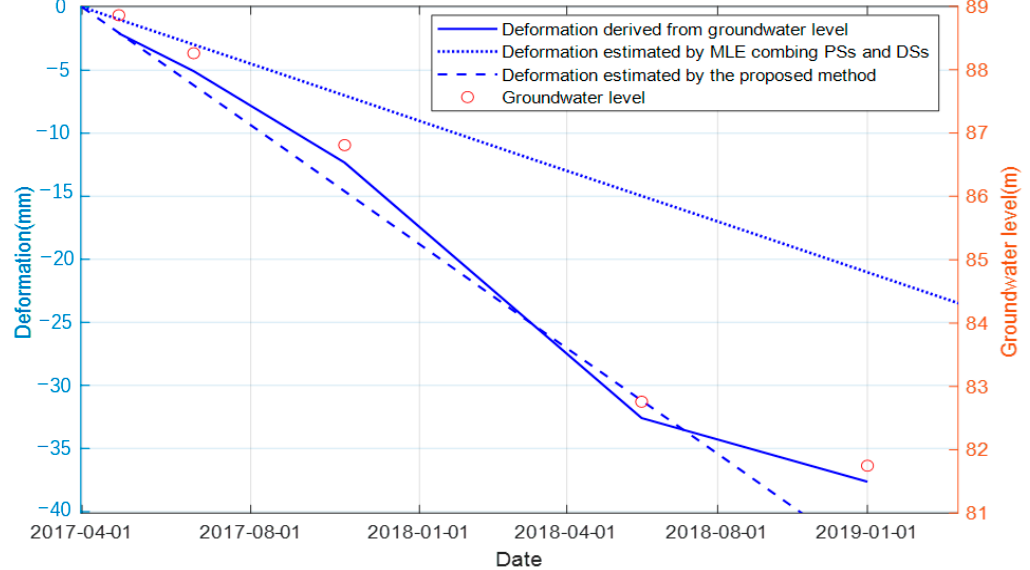
Figure 16. The correlation between the groundwater level and land deformation .